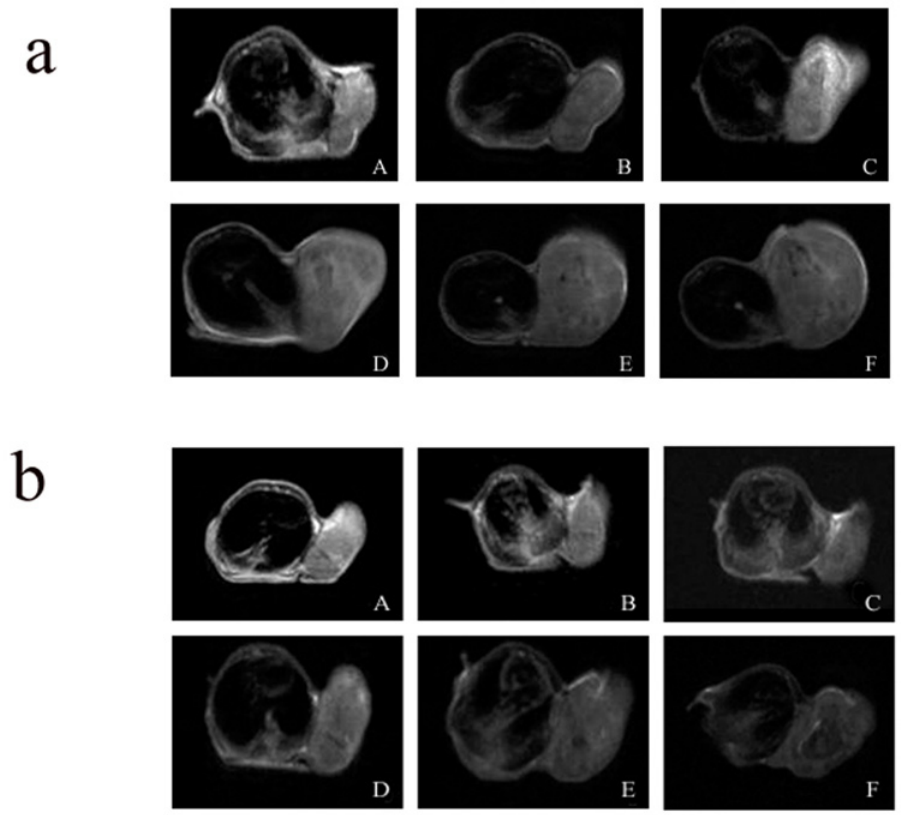
Figure 5. The T2WI of tumor xenografts in control group (a) and in experiment group (b) (A-F is represent respectively the T2WI of tumor xenografts before treatment, the day 6, 12,18,24 after 131 I treatment. The tumor volumes of control xenografts rapidly increased, and the tumor volumes of the experimental xenografts were slightly larger after 131 I treatment.).